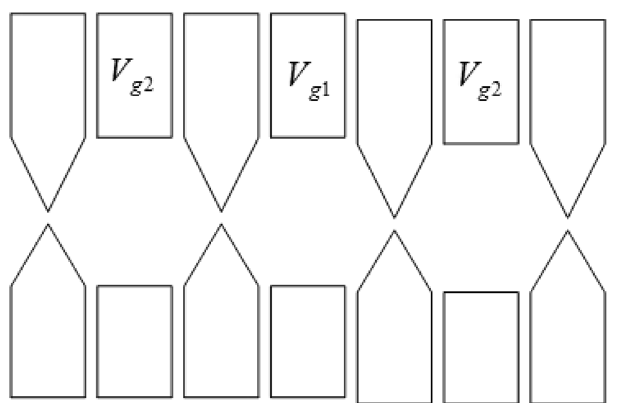
Figure 2. The sketch of the quantum dot array to realize the model (1). The  can be realized by tuning the voltage V g 1 and V g 2